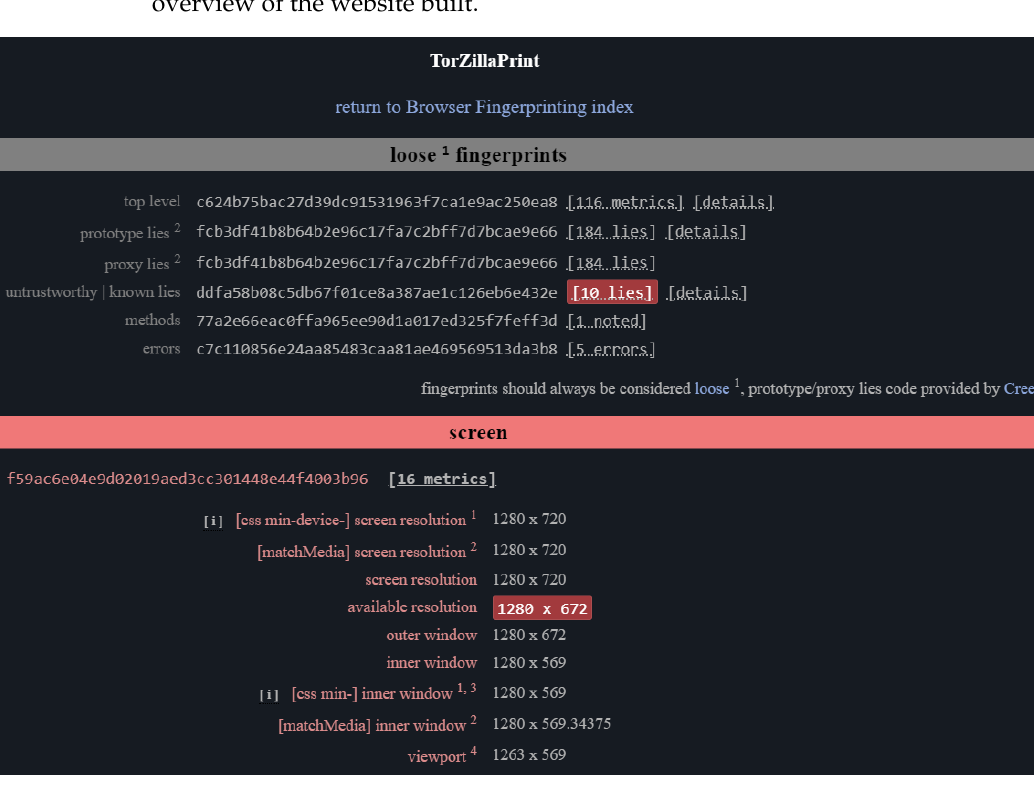
Figure 6. Example of attribute array values in the console log of the website.